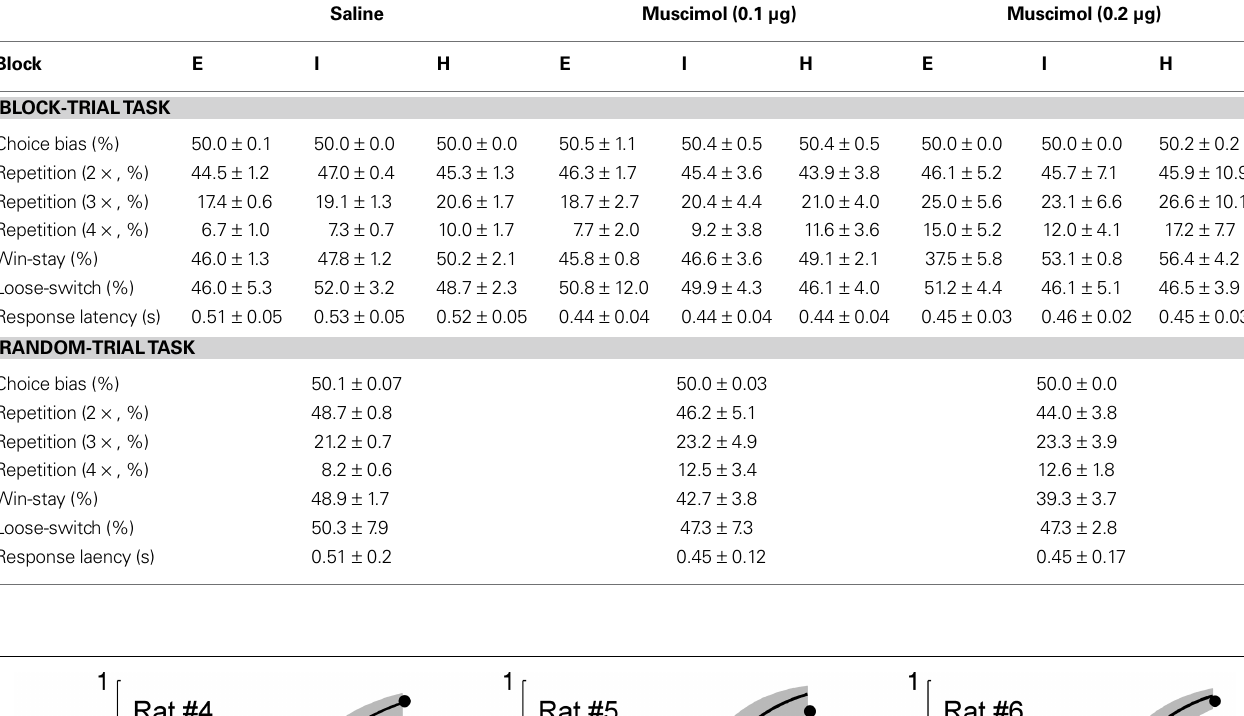
Table 2 | Behavioral measures related to choice strategy. The degree of choice bias, the proportion of consecutive same choices (repetition; 2–4), the proportions of win-stay and loose-switch choices, and the response latency are summarized for the block-trial and random-trial tasks (mean ± SEM; n = 3 animals in each task). E, I and H: easy, intermediate and hard blocks, respectively.